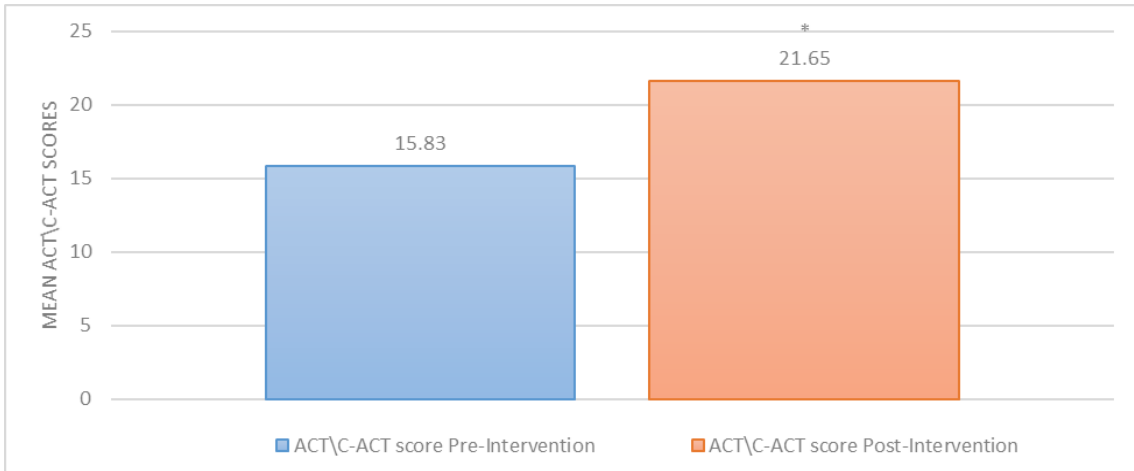
Figure 4. The increment in ACT\C-ACT score after interventional pharmacist counseling *Significant difference (P-value< 0.05) according to paired samples T-test.